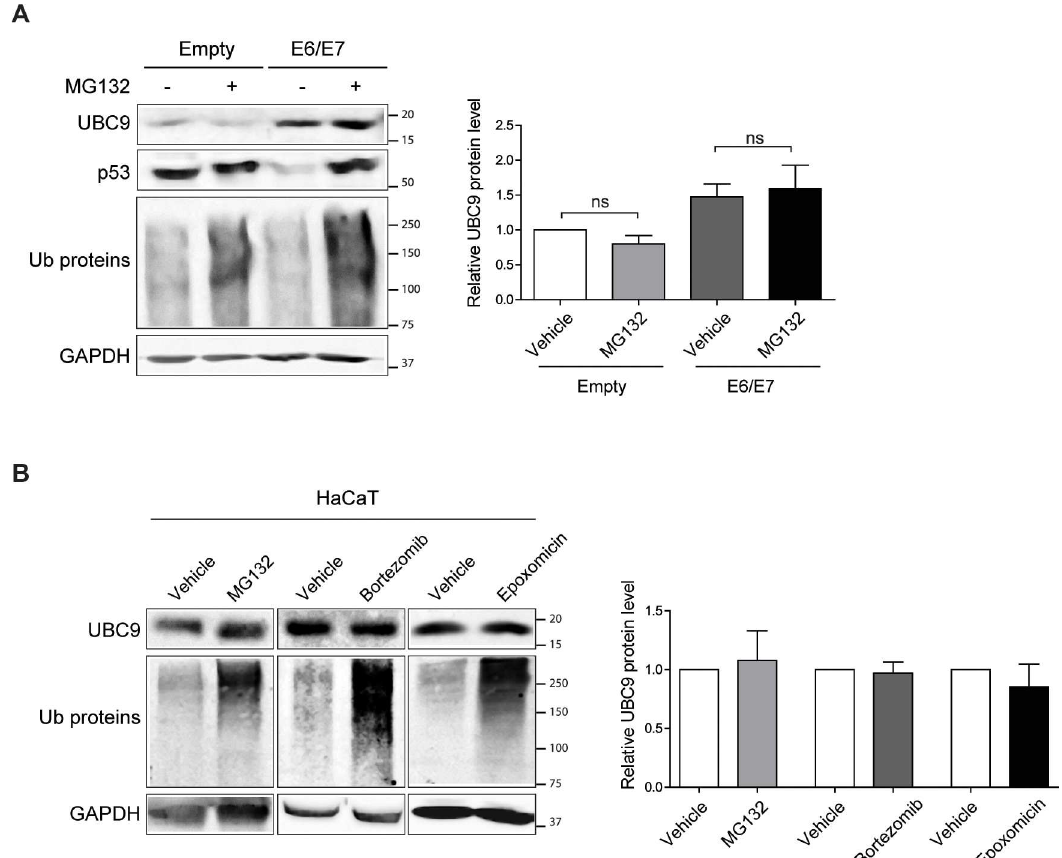
Fig 6. HPV16 E6/E7 disturb UBC9 degradation but not through the UPS. (A) Left: Representative WB of empty- or HPV16 E6/E7-transduced HKs treated with vehicle or MG132. Right: normalized UBC9 expression. Data are expressed as fold over the untreated empty-transduced HKs. Bars represent means ± SEM of n = 5 different biologicalreplicates. ns: not significant(Kruskal–Wallis one-wayANOVA with Dunn’spost hoc test) comparedto vehicle control groups. (B) Left: Representative WB of HaCaT cells treated with vehicle or the indicatedproteasome inhibitors.Right: normalized UBC9 expression. Data are expressedas fold over untreatedcells. Bars represent means ± SEM of n = 6 different biological replicates. ns: not significant(Kruskal–Wallis one-wayANOVA with Dunn’spost hoc test) comparedto vehiclecontrol